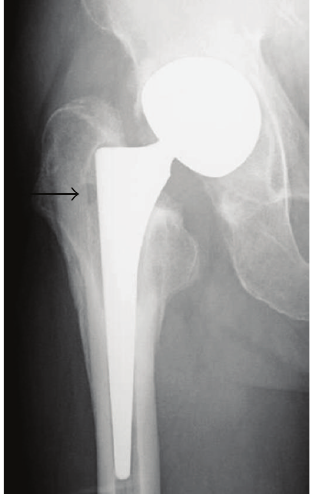
Figure 1: Radiograph showing a circular bone resorption (arrow).